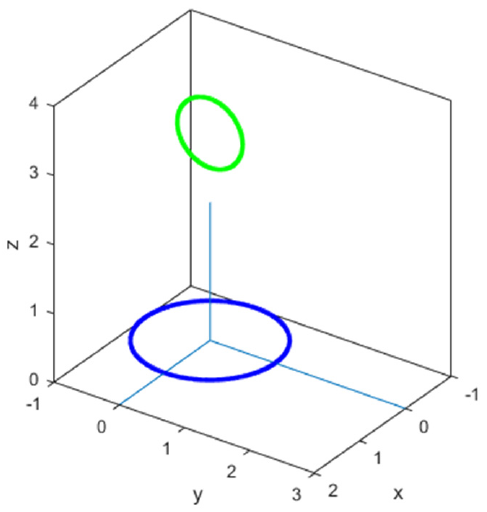
Figure 10. Case (b): two perpendicular circular loops. Not a singular case, ( a = 1, b = c = 0, L = l = 1).